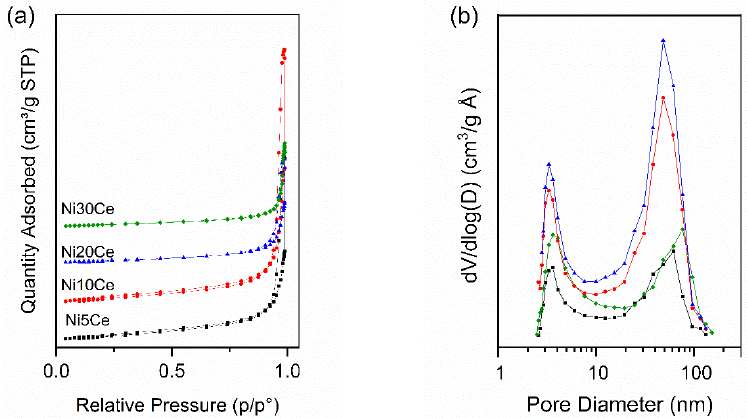
Figure 3. Brunauer–Emmet–Teller (BET) analysis of NixCe catalysts: ( a ) nitrogen adsorption and desorption isotherms as a function of p/p°; ( b ) PSD pore size distribution.